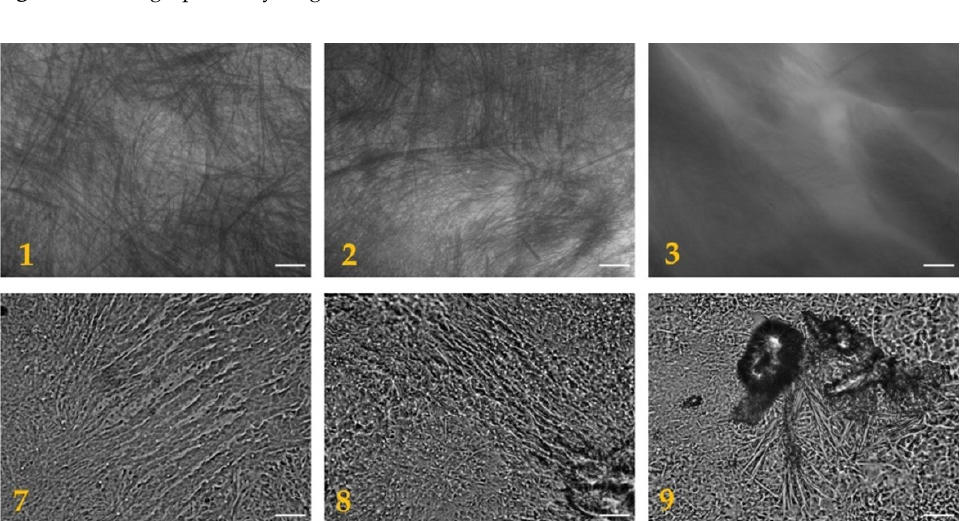
Figure 3. Optical microscope images of dried hydrogels 1 – 3 (scale bar: 100 µm) and 7 – 9 (scale bar: 25 µm).